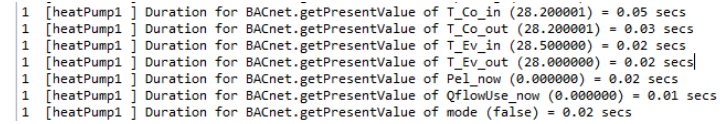
Figure 9. Part of log file on reading the heat pump data points over